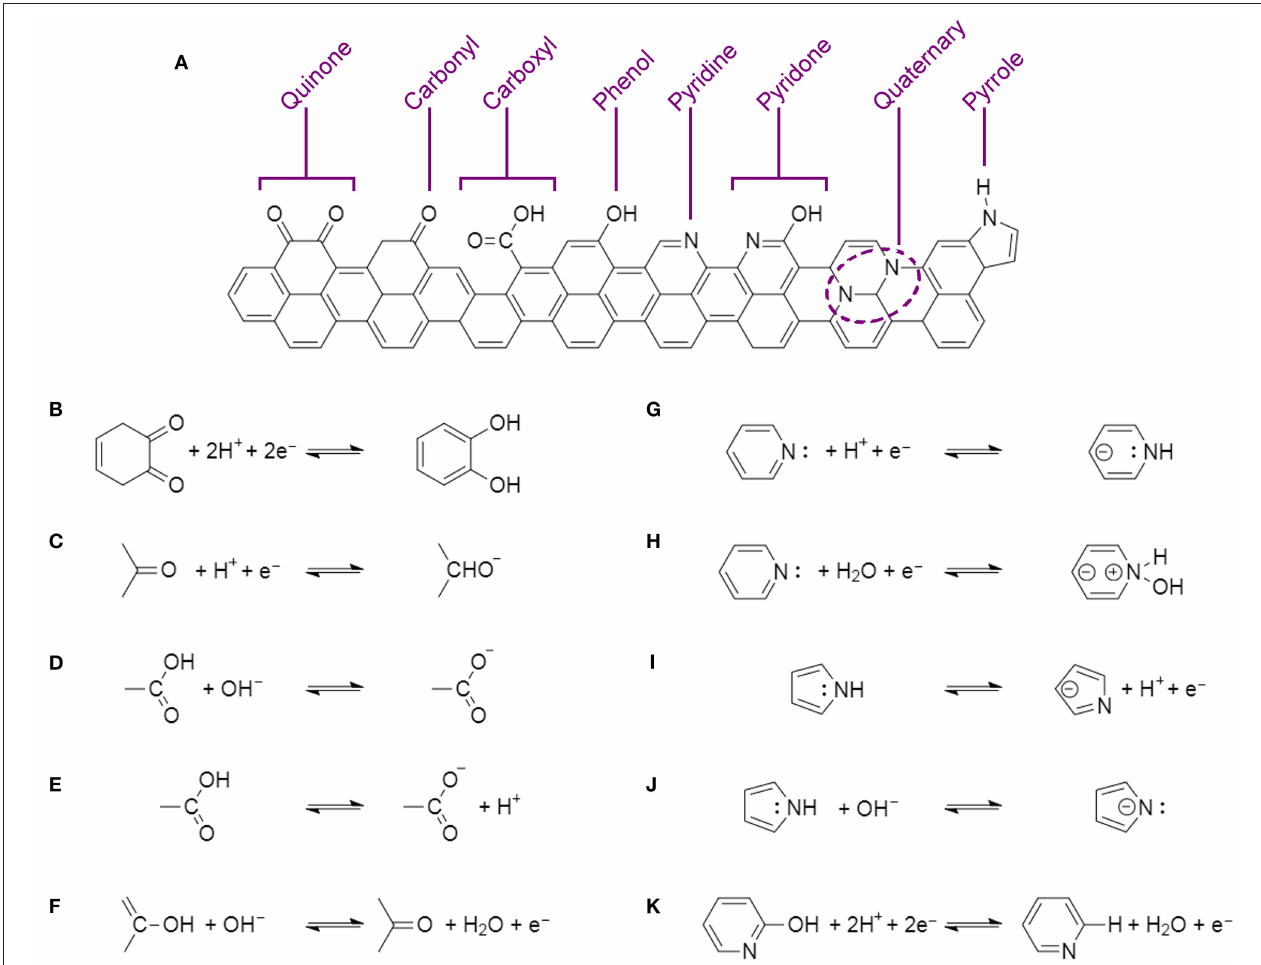
FIGURE 8 | (A) Oxygen and nitrogen surface functional groups commonly associated with the enhanced performance of carbon-based SCs. Proposed reactions of such (B–F) oxygen and (G–K) nitrogen surface functionalities ( Chen et al., 2012; Deng et al., 2016; Sánchez-Sánchez et al.,